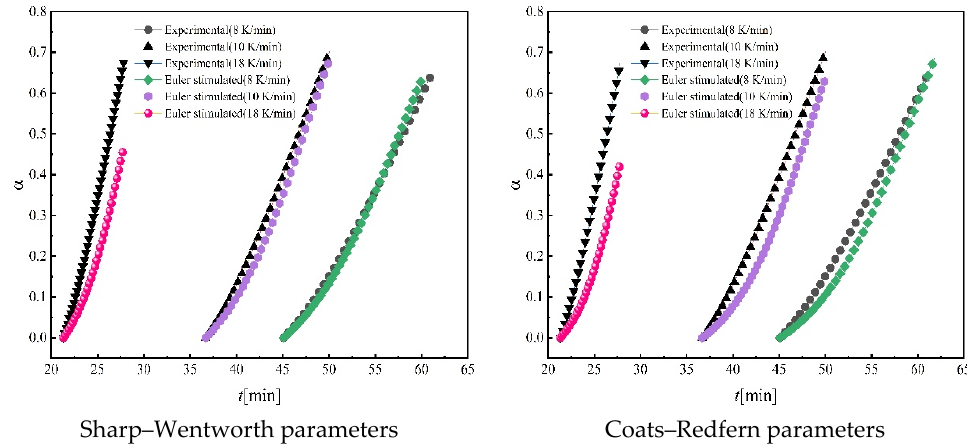
Figure 5. Experimental and predicted data using Sharp–Wentworth and Coats–Redfern parameters of Fe 3 O 4 → Fe by explicit Euler method.